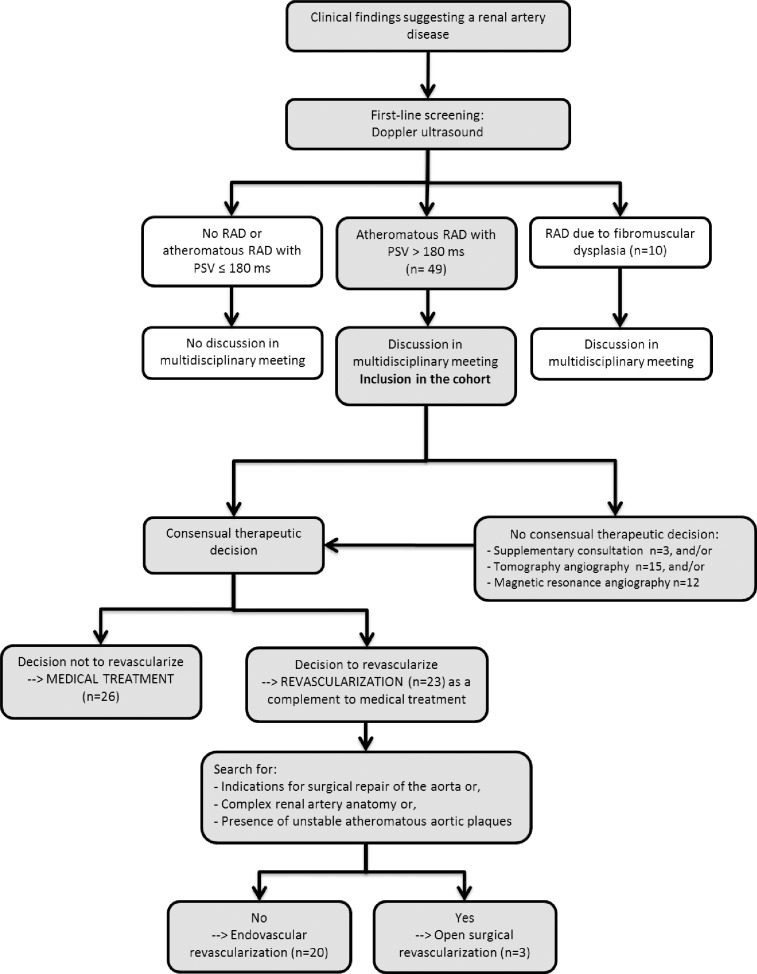
Flowchart.PSV: Peak Systolic Velocity; RAD: Renal Artery Disease.